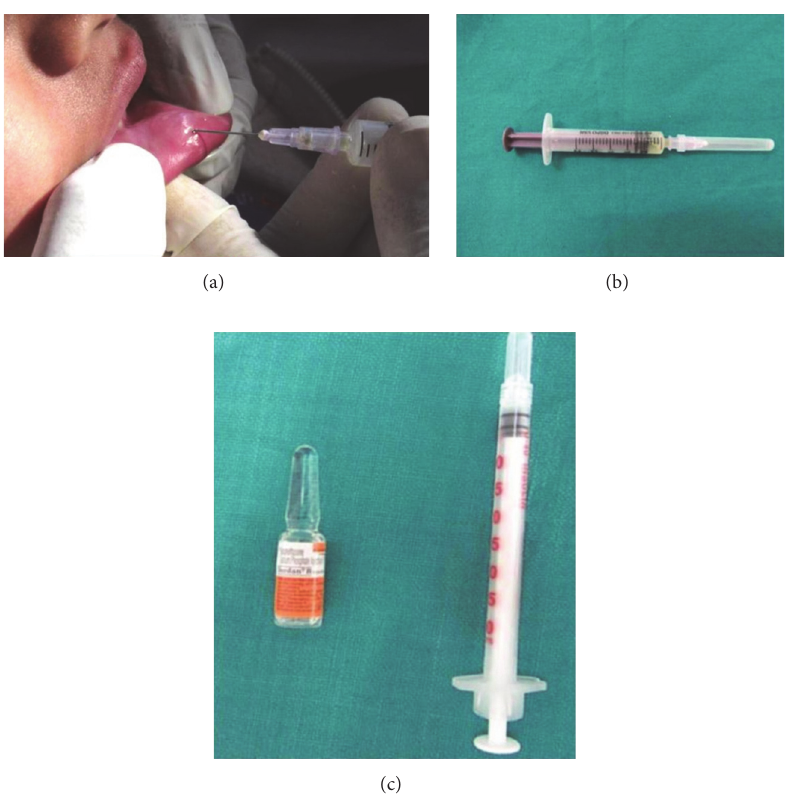
Figure 1: (a) Mucus aspirated by 18-gauge needle and syringe, (b) syringe with mucus aspirate, and (c) 1mL of betamethasone intralesional injection and 31-gauge insulin